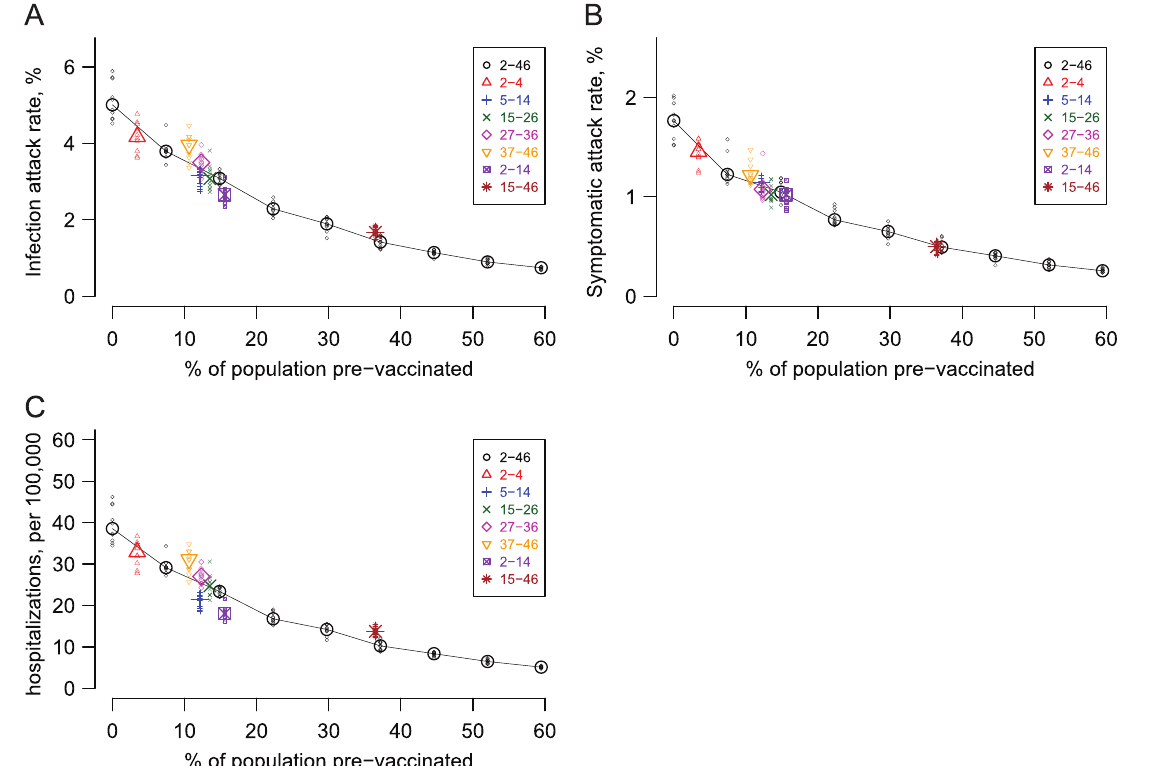
Figure 6. The simulated effects of pre-vaccinating different age cohorts against dengue. The larger points represent the median attack rates (y-axis) of ten stochastic simulations run when a percentage of the total population (x-axis) is pre-vaccinated. The results from the individual simulations are plotted as small points to show the stochastic variation. The black Os, connected by lines, represent the effect of pre-vaccinating different fractions of individuals from 2 to 46 years old, from 0 to 80% of this cohort, which translates to 0 to 59.5% of the total population. The other symbols are the results from targeting 70% of individuals in narrower age cohorts (expressed in years in the legends) for pre-vaccination. Pre- vaccinating a particular age group can be considered more efficient than vaccinating an equivalent number of people from ages 2 to 46 if it results in a lower attack rate (i.e., the point falls below the line). The vaccine confers immunity to 70% of those vaccinated in the model. (A) Overall infection attack rate vs. pre-vaccination fraction. (B) Overall symptomatic (uncomplicated dengue fever) attack rate vs. pre-vaccination fraction. (C) Overall DSS/ DHF cases (hospitalizations) vs. pre-vaccination fraction.